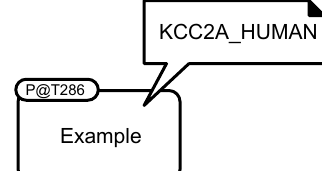
Figure 2.56: Example of annotations adding information to the description of the trans- phosphorylation of CaMKII. Note that three different types of links are used between an- notation nodes and annotated elements. However, it is recommended to use a consistent scheme within a map.